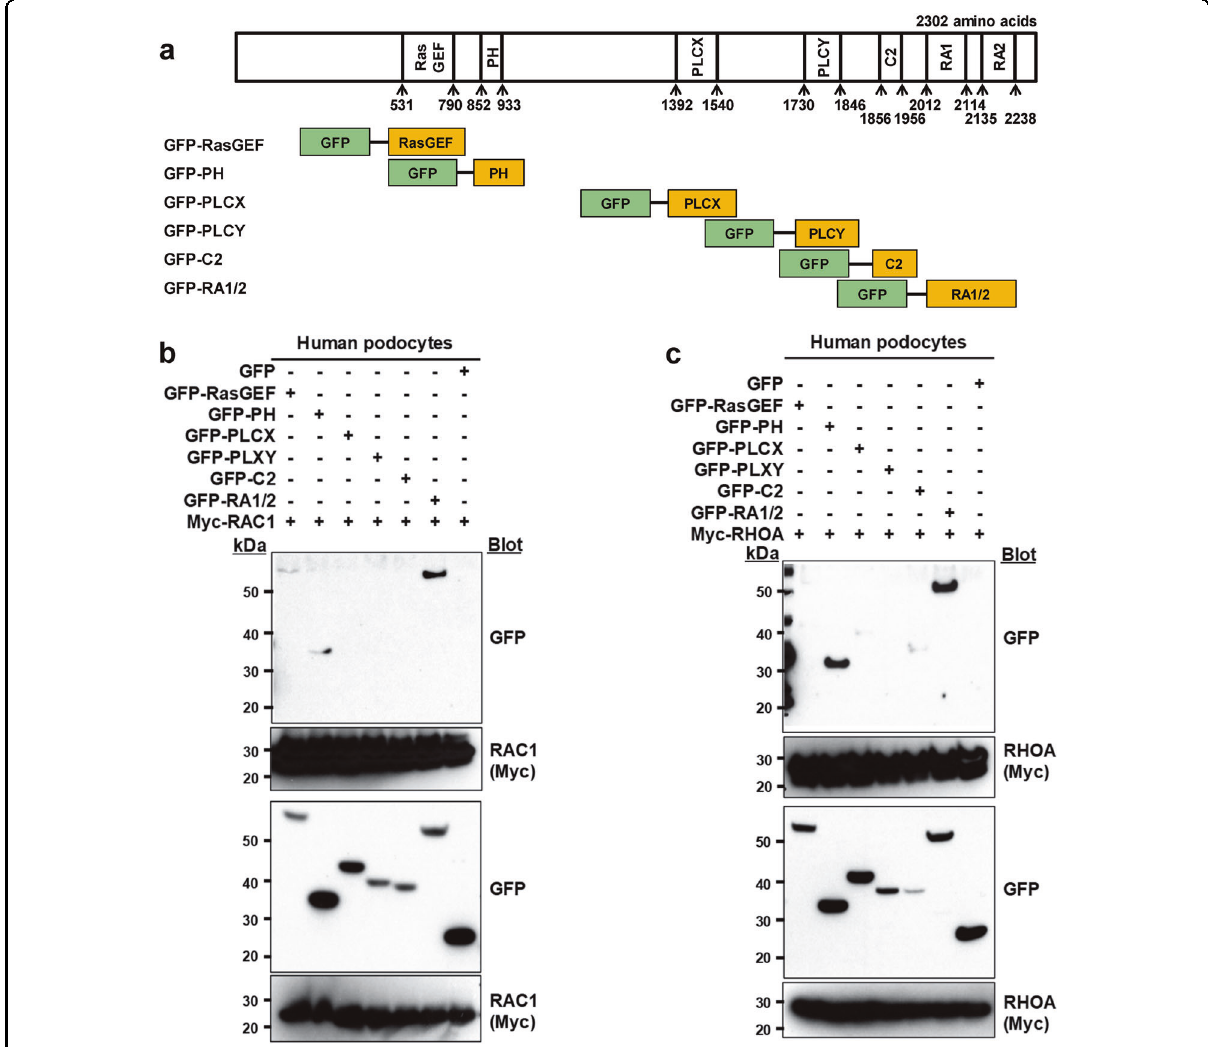
transfected into podocytes, and immunoprecipitation was performed using anti-Myc agarose beads. Notably, both RAC1 and RhoA bind to PLCE1 through the PH and RA1/2